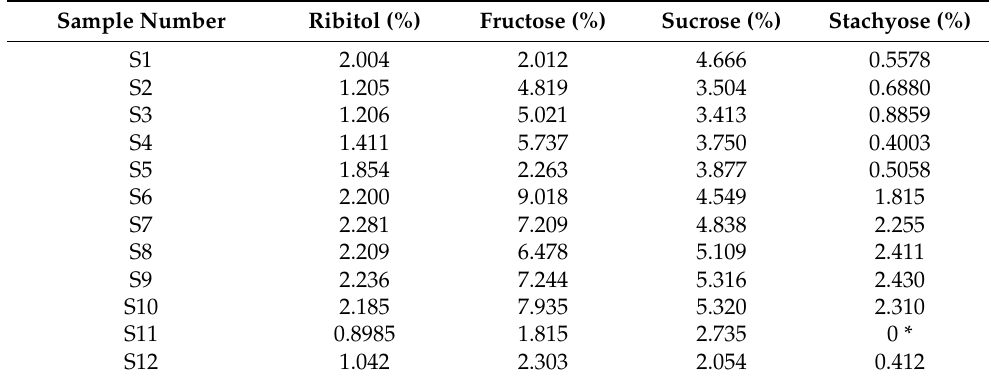
Table 8. Quantitative component content determination results for 12 batches of Xiaochaihu